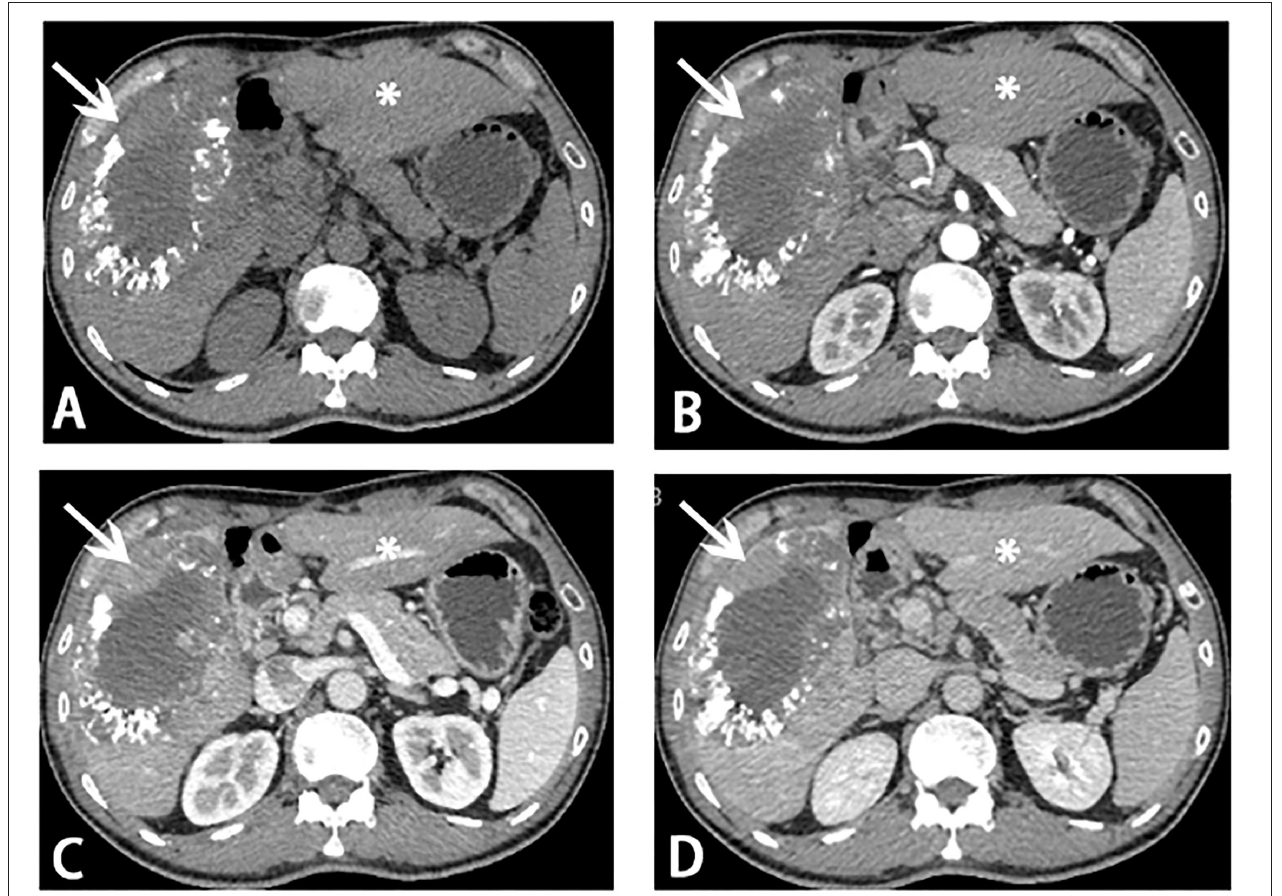
FIGURE 2 | Computed tomography (CT) scans before stage II ALPPS. Reduce of tumor load (white arrow) and hypertrophy of segments 2 and 3 (asterisk) was showed on CT scans. (A) Plain scan; (B) arterial phase; (C) portal venous phase; (D) venous